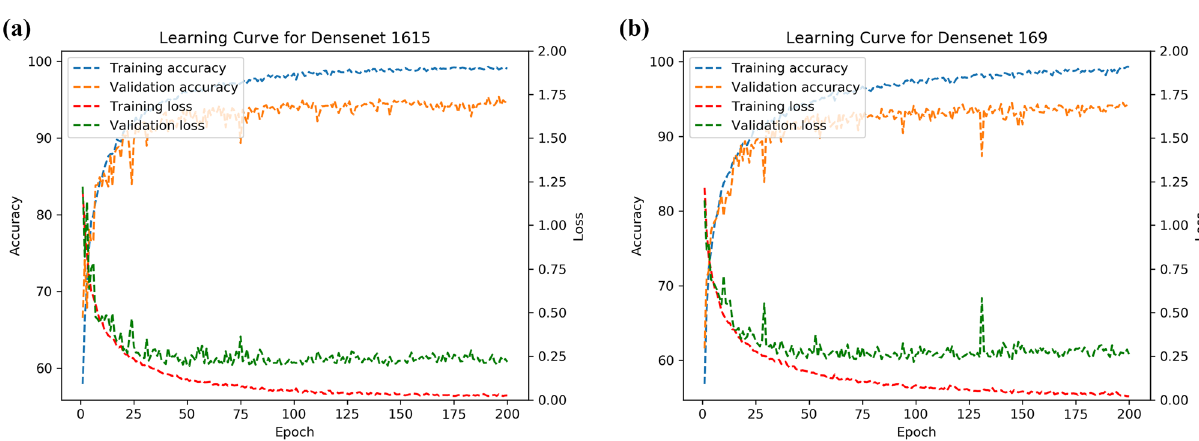
Figure 5. The learning curves of 2 selected models, DenseNet 1615 ( a ) and DenseNet 169 ( b ).